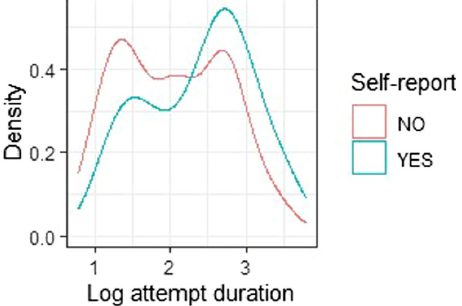
FIG. 2. Density distribution of log (base 10) attempt duration of the assessment component of module E08.